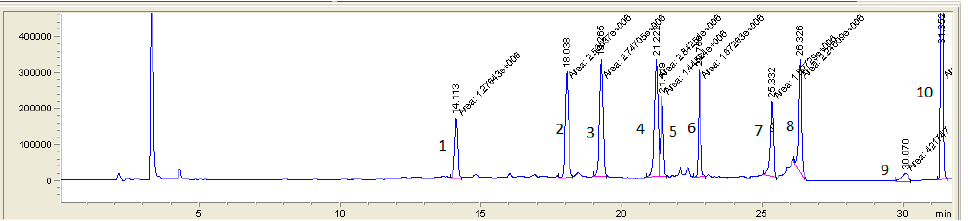
Figure 4. LC ‑ MS (SIM) chromatogram of pig feces sample spiked with all analyzing antibacterial